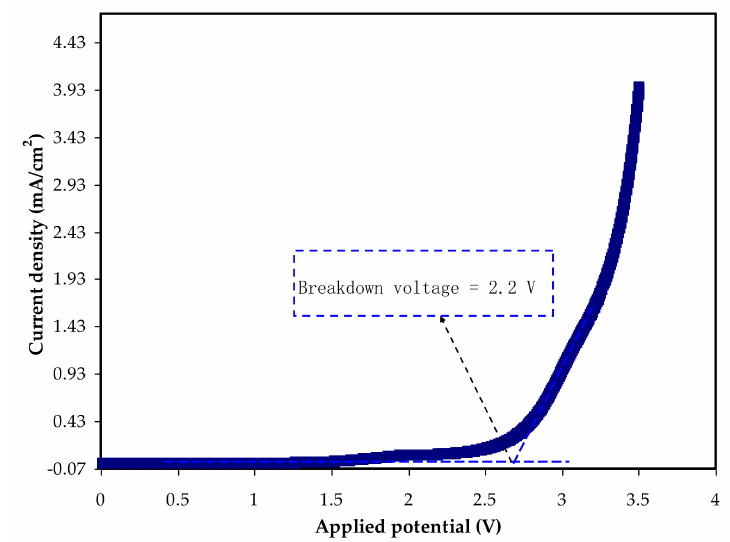
Figure 6. LSV plot for the highest conducting